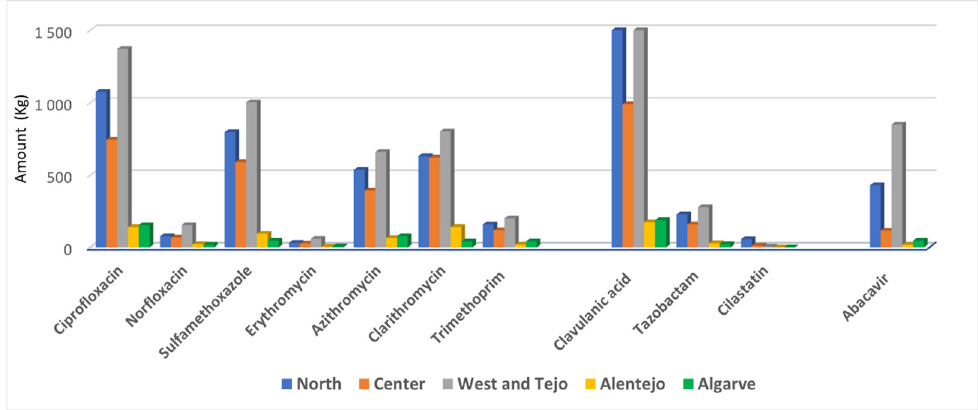
Figure 3. Amount of detected pharmaceuticals consumption per Portuguese region.